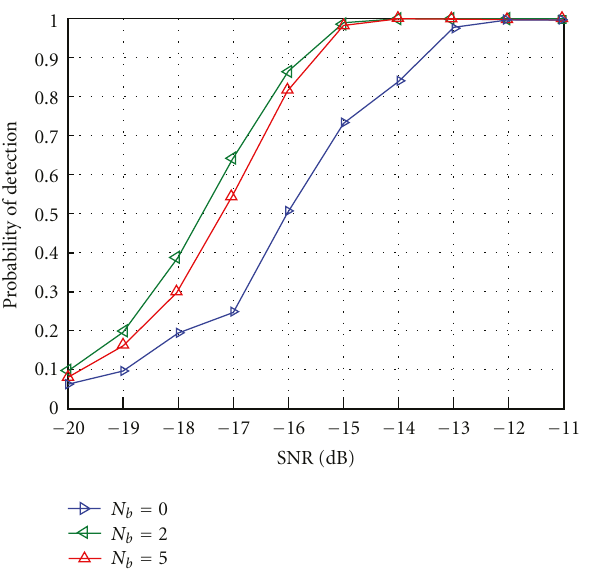
Figure 4: Influence of U (with N b =